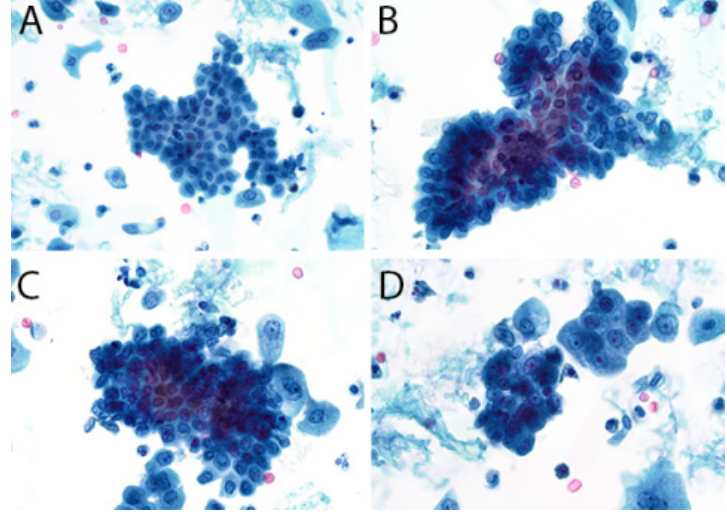
Figure 1. ( A ), The assessment of cytologic atypia is more easily performed when cellular overlap is minimal. In this sheet, it is easy to appreciate the uniformity of the nuclei. ( B ), The nuclei at the edges clearly have bland chromatin and lack hyperchromasia. In the center of the fragment, nuclear overlap can create a sense of nuclear hyperchromasia and elevated N/C ratio; in addition, chromatin pattern and nuclear contours are obscured. ( C ), Many of the cells in this fragment appear to have elevated N/C ratios and contain nuclear contour irregularities. Their benign nature may be suggested by the overlying umbrella cells, seen at the right-hand side of the fragment. However, umbrella cells may also be seen on the surface of LGUN, CIS, and even HGUC; thus, this feature is not reassuring on its own. ( D ), Two small fragments containing predominantly umbrella cells. They can be identified by their abundant and granular cytoplasm; however, the cells in the fragment on the left are overlapping and appear to have elevated N/C ratios. In these instances, the distinct chromatin pattern of umbrella cells can be useful: a single nucleolus together with a condensed rim of chromatin around the nuclear border.